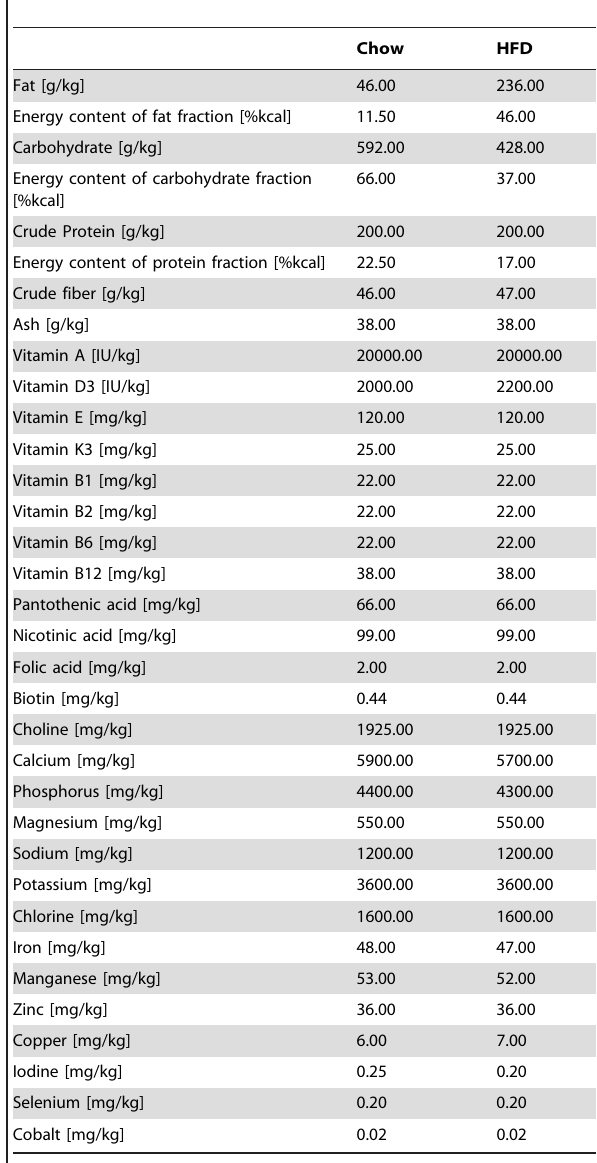
Table 1. Compositions of Altromin control chow and high fat diet (HFD; C 1080) used in the present